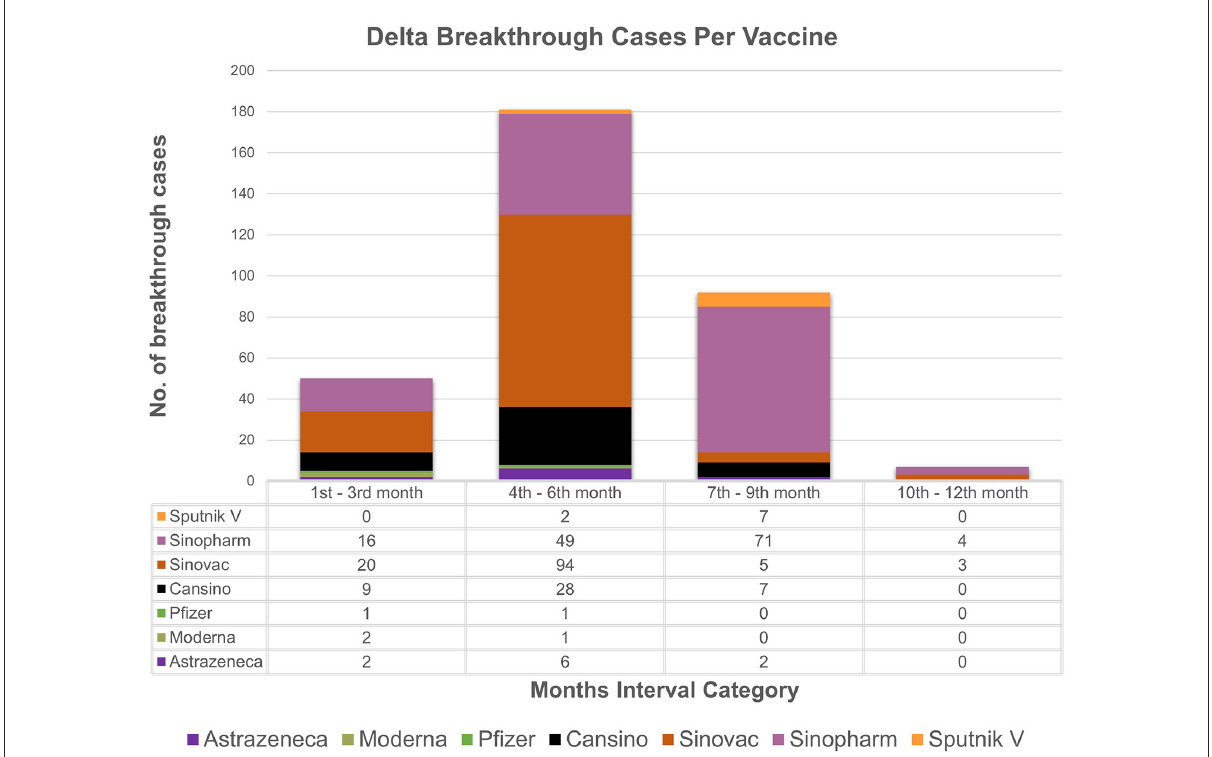
FIGURE2 Breakthrough cases representation: the month’s interval between being fully vaccinated and testing positive for delta with respect to vaccines. X-axis represents month’s interval while y-axis represents counts of breakthrough